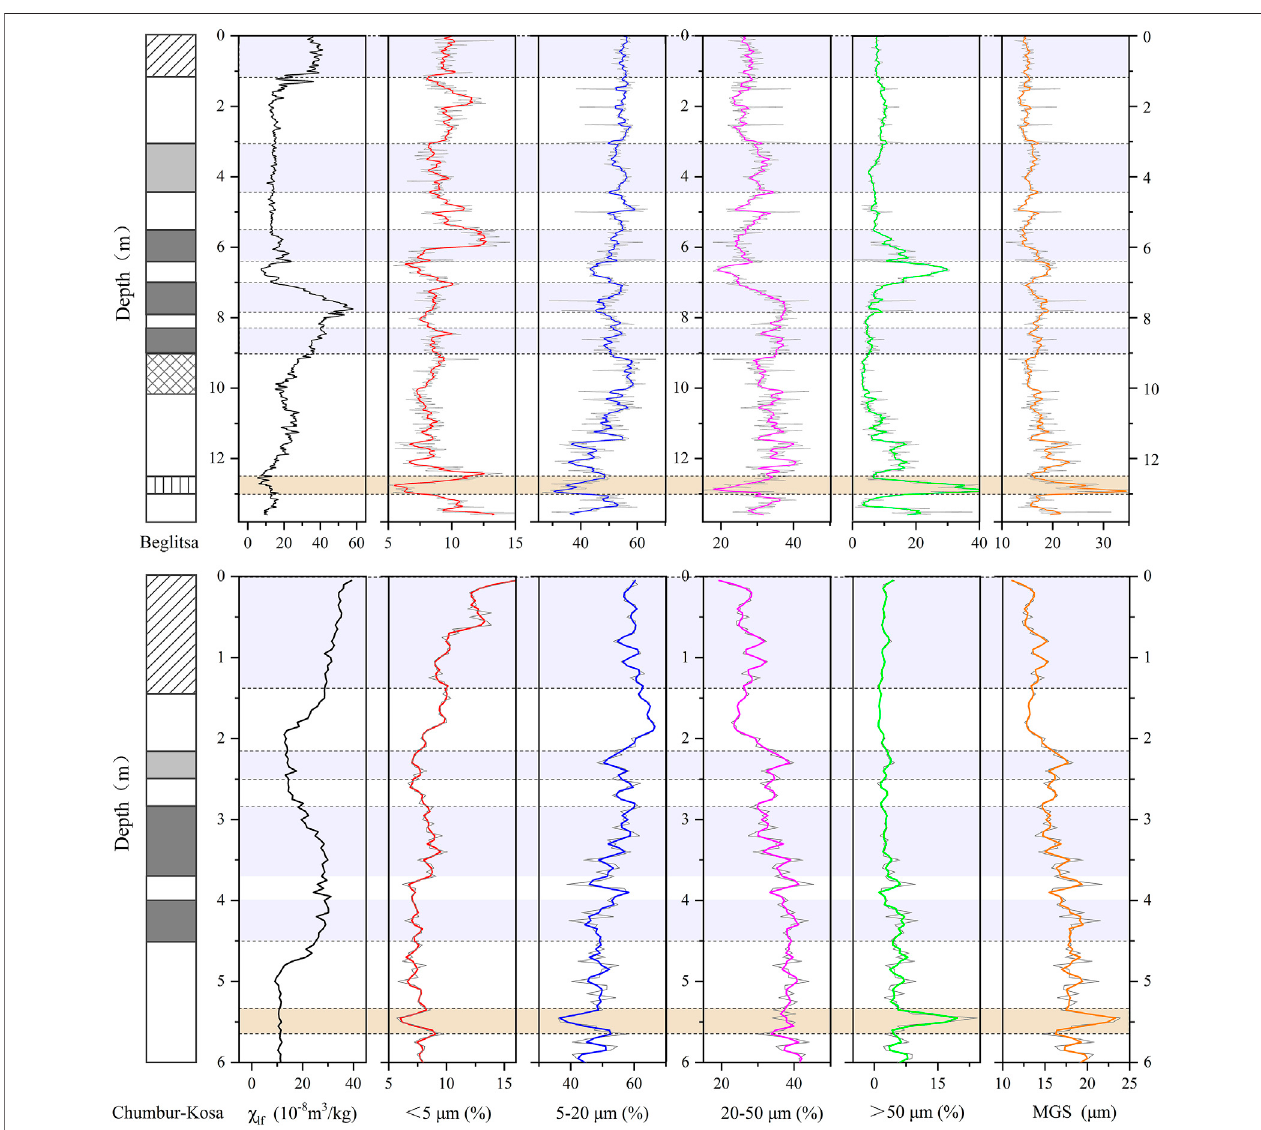
FIGURE 3 | Variations in different grain size (GS) fractions and median grain size (MGS) of the Beglitsa and Chumbur-Kosa sections against χ lf (all GS data have been smoothed by fi ve points using adjacent-averaging method).